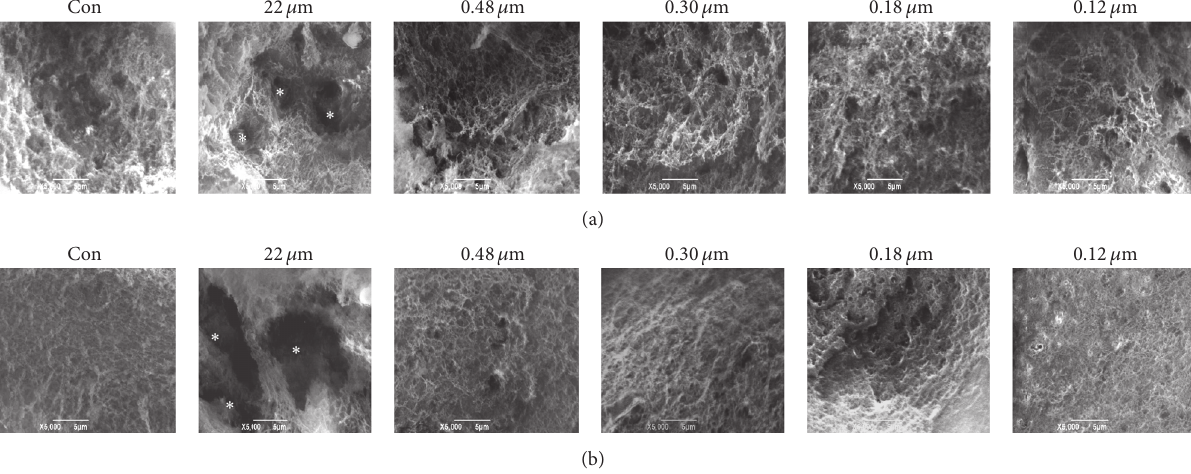
Figure 5: SEM images of silver carp surimi gels with different size of fish bone particles and thermal treatments. (a) Gel cooked at 90 ∘ C for 30 min; (b) gel incubated at 40 ∘ C for 1h followed by 90 ∘ C cooking for 30min. Con: control sample, without added fish bone. Numbers designate average size of fish bone